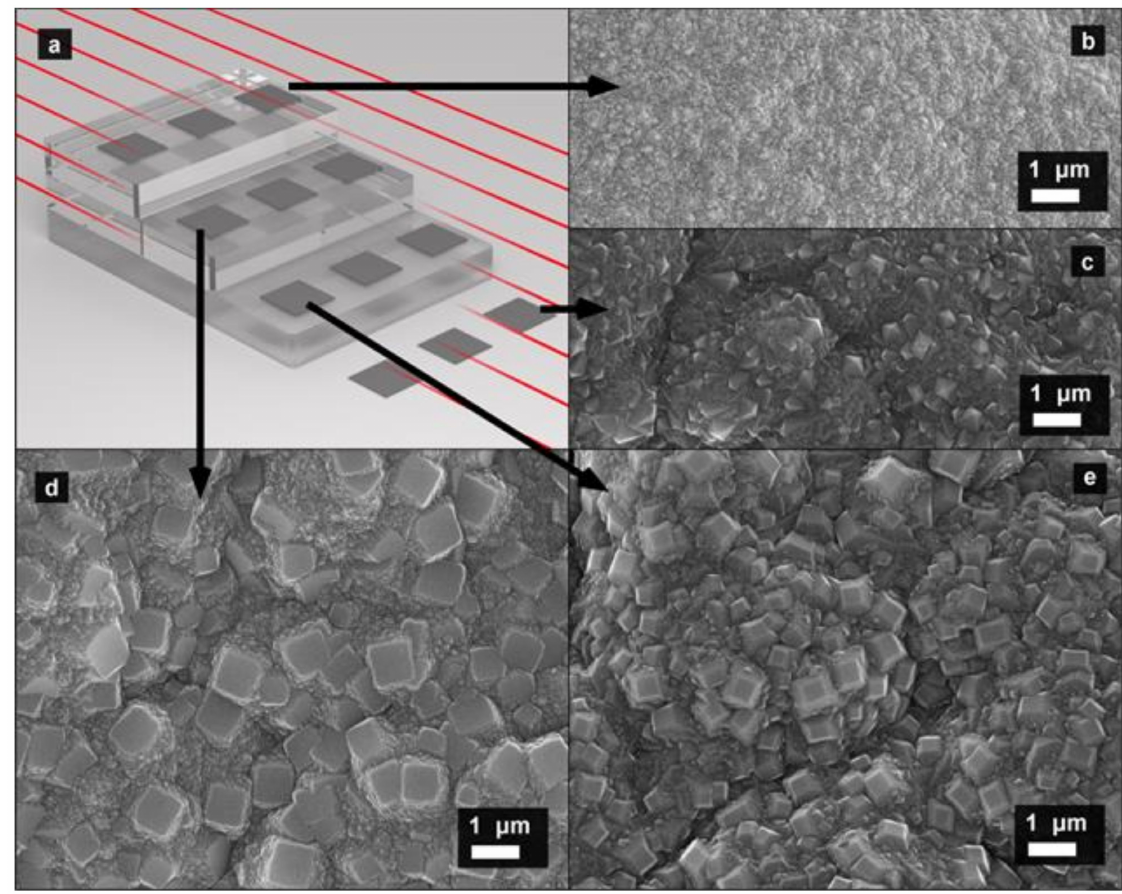
Figure 1. Typical scanning electron microscopic images of polycrystalline diamond films obtained using hot-filament chemical vapor deposition: ( a ) schematic illustration of the substrate holder configurations used for the synthesis of different diamond films in hot-filament chemical vapor deposition: three semitransparent gray tiles represent a stair-like quartz substrate holder, the 12 smaller dark gray squares are Si substrates, and the red lines are hot filaments of the HF CVD system; ( b – e ) SEM images for samples grown on substrates with a different location, indicated by